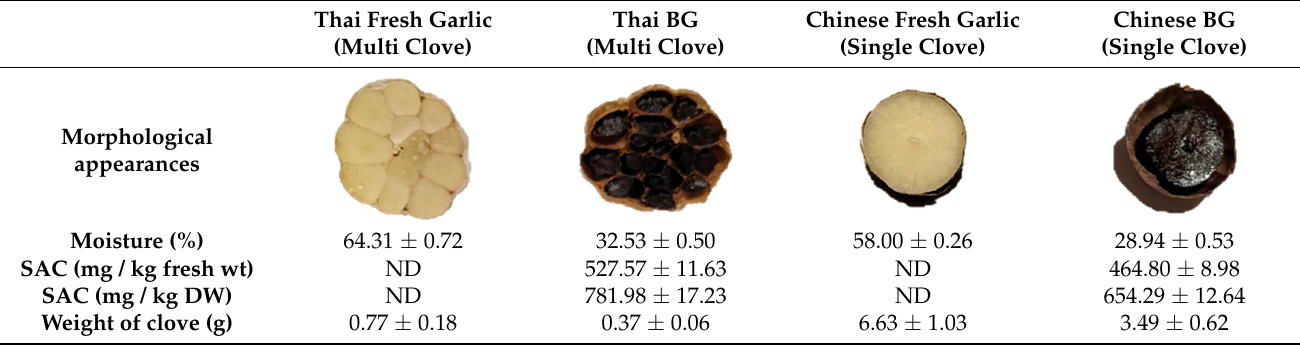
Table 2. The characteristics data of fresh garlic, Thai BG and Chinese BG when treated with the thermal process at 70 °C, 80% RH by maintained in black garlic fermentation chamber for 12 days. Thai Fresh Garlic